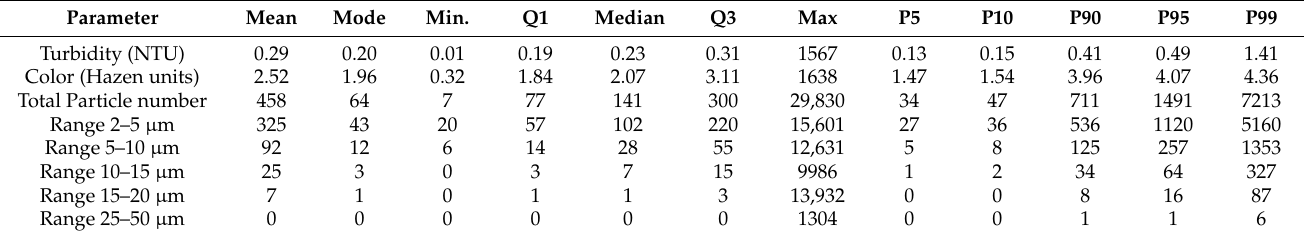
Table 1. Statistical parameters.